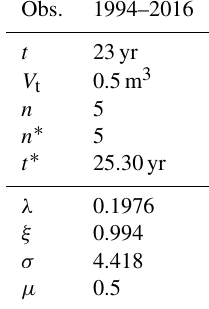
Table 2. Input and results of the analyses performed at the Buisson site. The estimates of the parameters of the distribution are reported in the bottom rows.